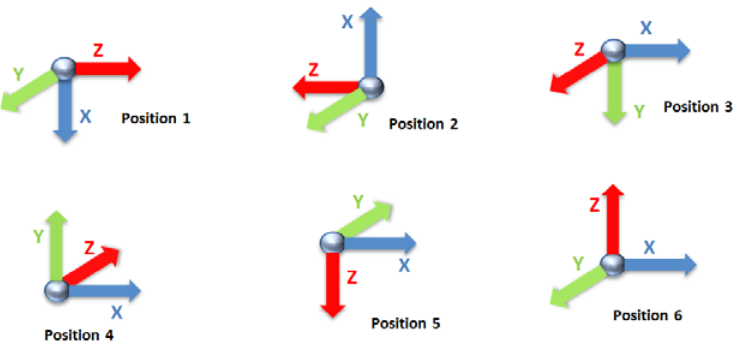
Figure 3. Accelerometer calibration